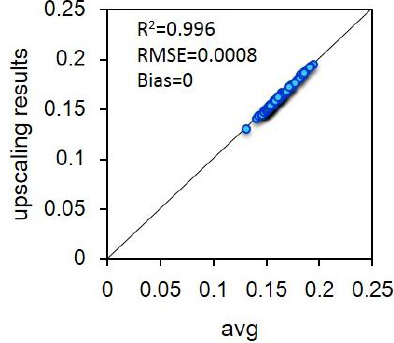
Figure 13. Scatterplots between daily time series of the average value based on all measurement nodes and the upscaling results in the field scale.